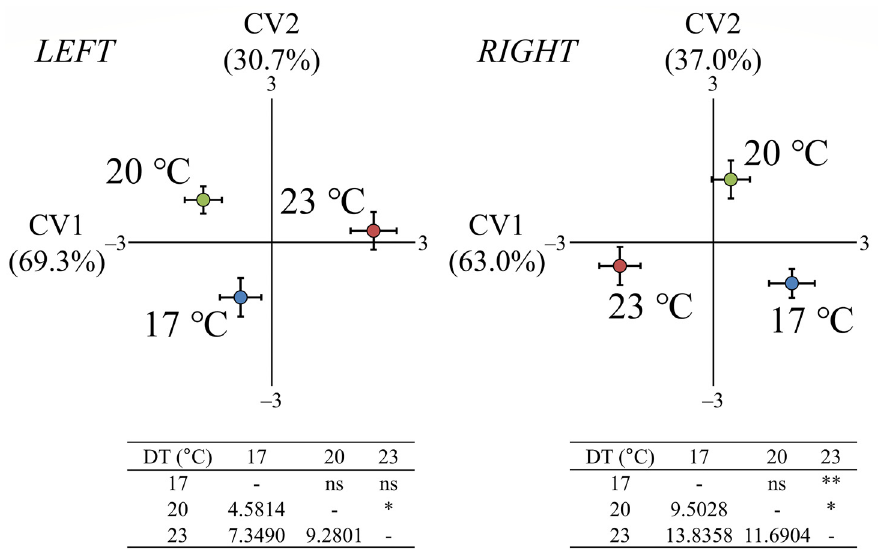
Figure 2. Effect of developmental temperature (17, 20, or 23 ◦ C) on the otolith shape of seabream metamorphosing larvae taken at 56–58 dph (days post-hatching). Means ( ± 2 SE) of the canonical scores are presented. Numbers in brackets are equal to the percentage of shape variance explained by each canonical variate (CV) axis. Squared Mahalanobis distances between the different groups and the respective significance levels are given for both left and right otoliths in the tables below the CV graphs. ns p > 0.05, * p < 0.05, ** p <